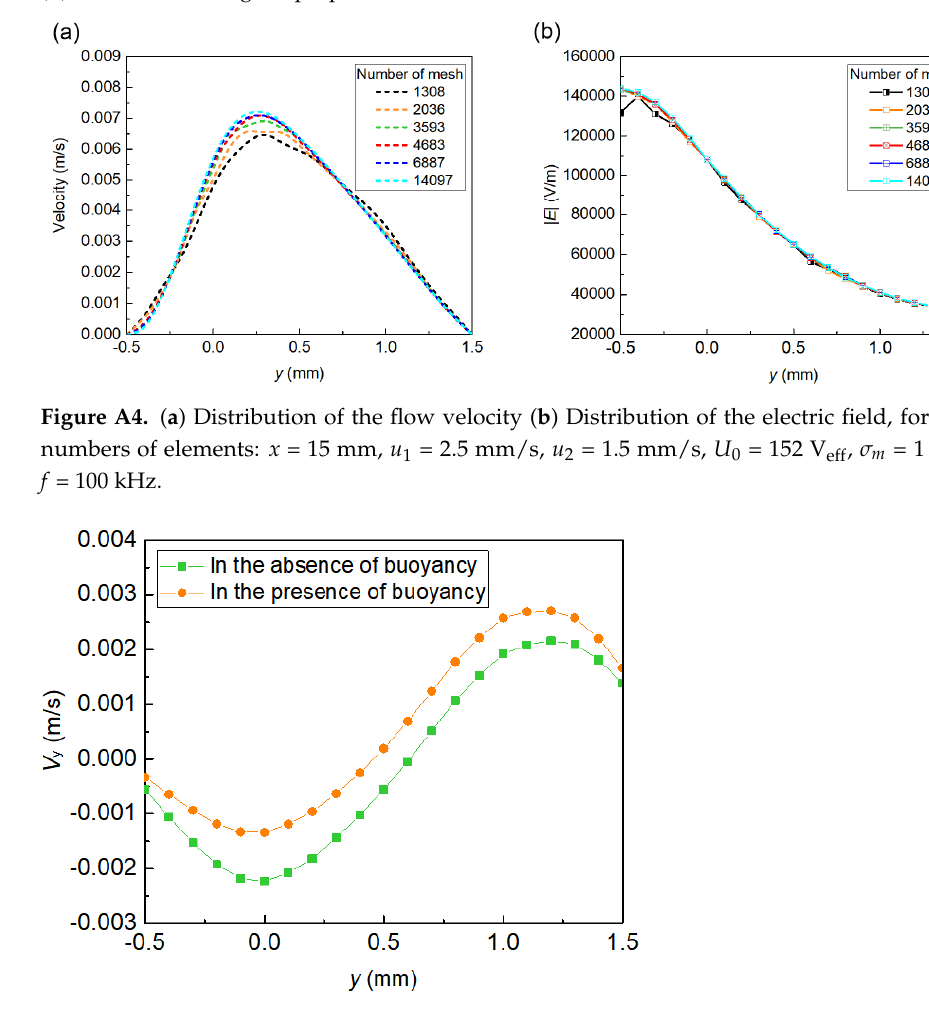
Figure A6. Variation of the temperature average on the x location.